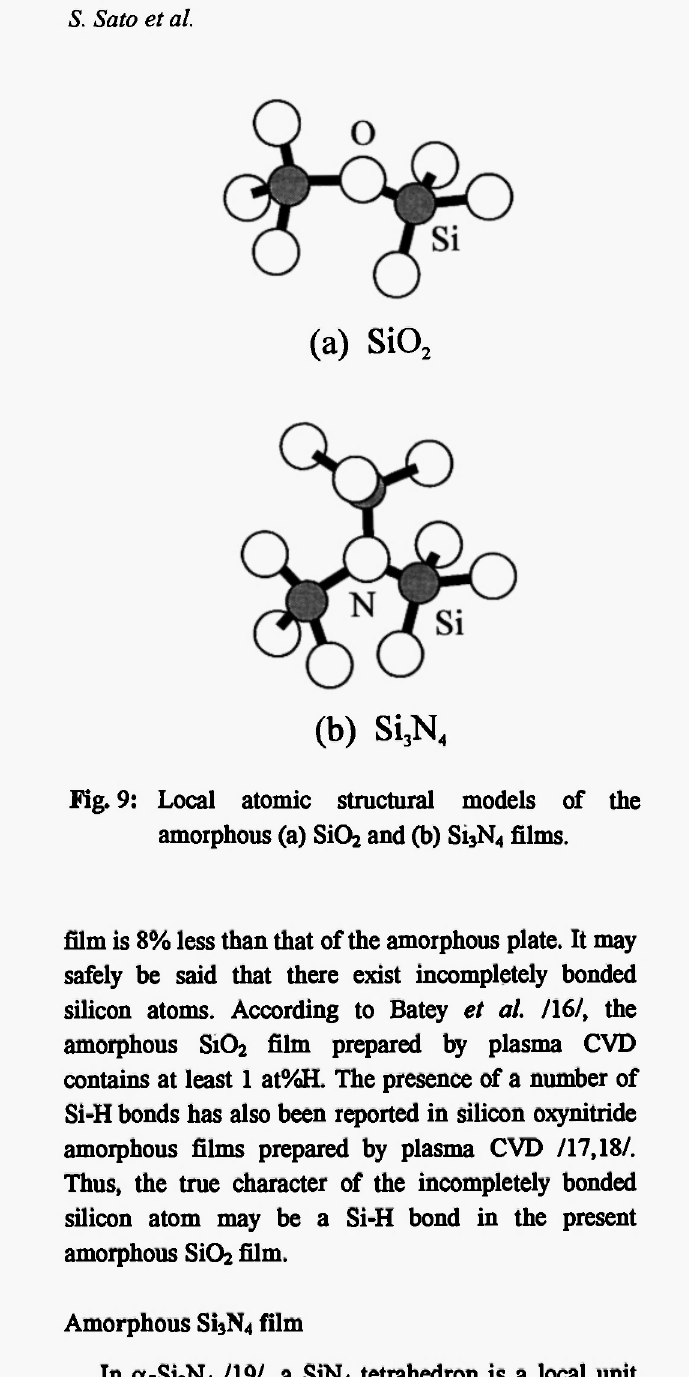
Fig. 9: Local atomic structural models of the amorphous (a) Si0 and (b) S13N4 2